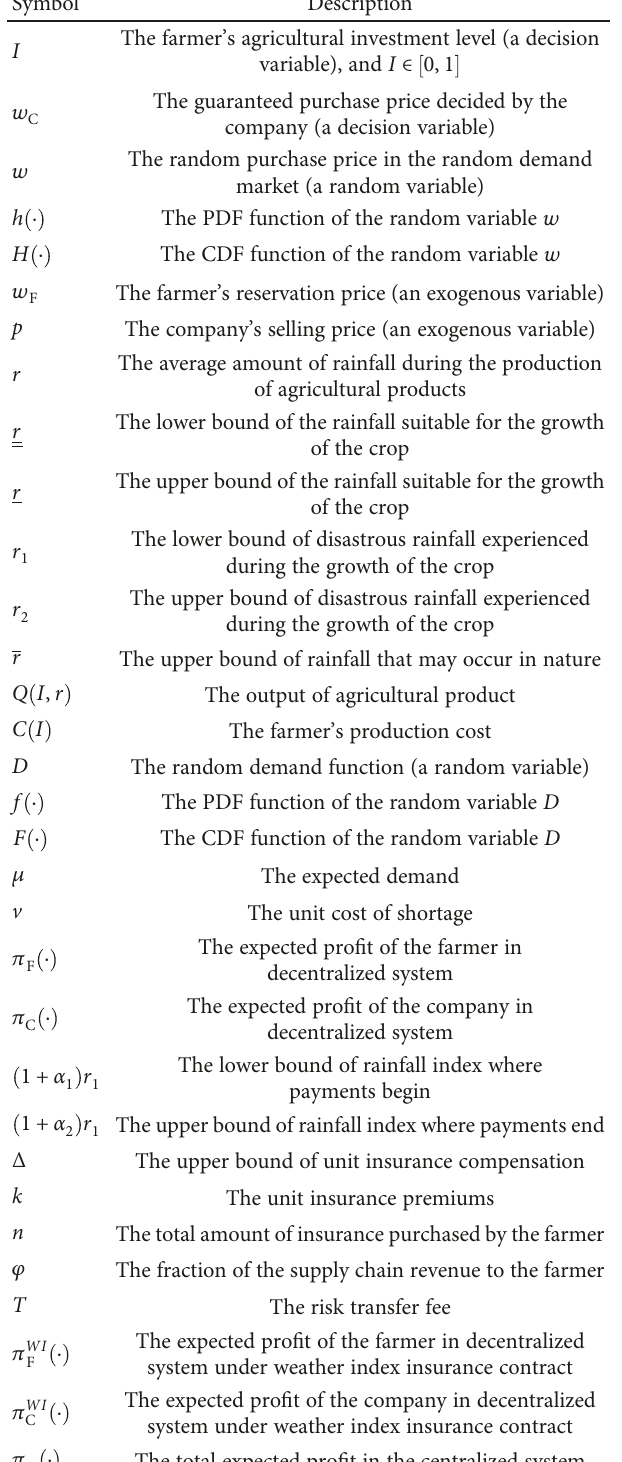
Table 1: List of notation.